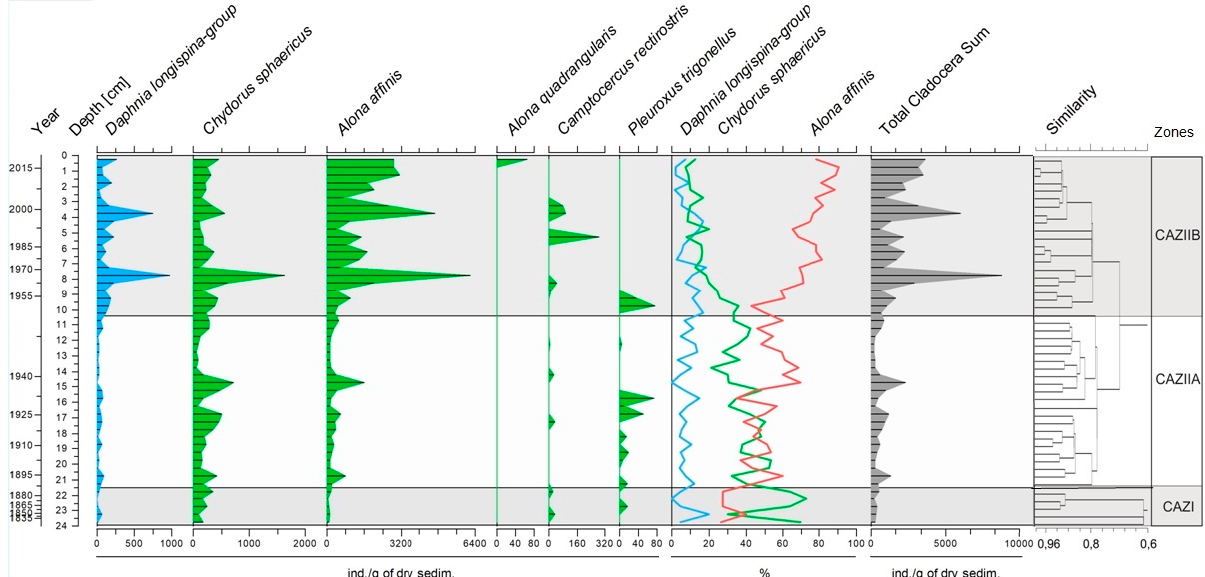
Figure 5. Stratigraphy diagram of the absolute (ind./1 g of dry sediment) and relative (%) abundances of all Cladocera species recorded in the VRP sediment core. Colours represent: (cid:4) pelagial taxa, (cid:4) littoral